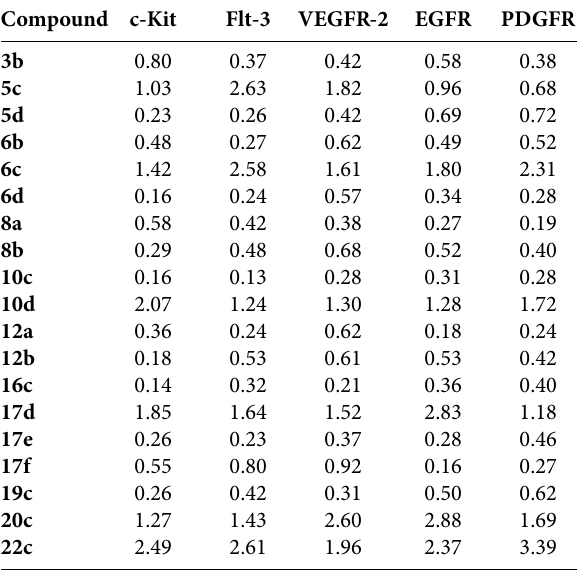
Table 2. Inhibition of tyrosine kinases (enzyme IC 50 in nM) by com- pounds 3b , 5c , 5d , 6b , 6c , 6d , 8a , 8b , 10c , 10d , 12a , 12b , 16c , 17d